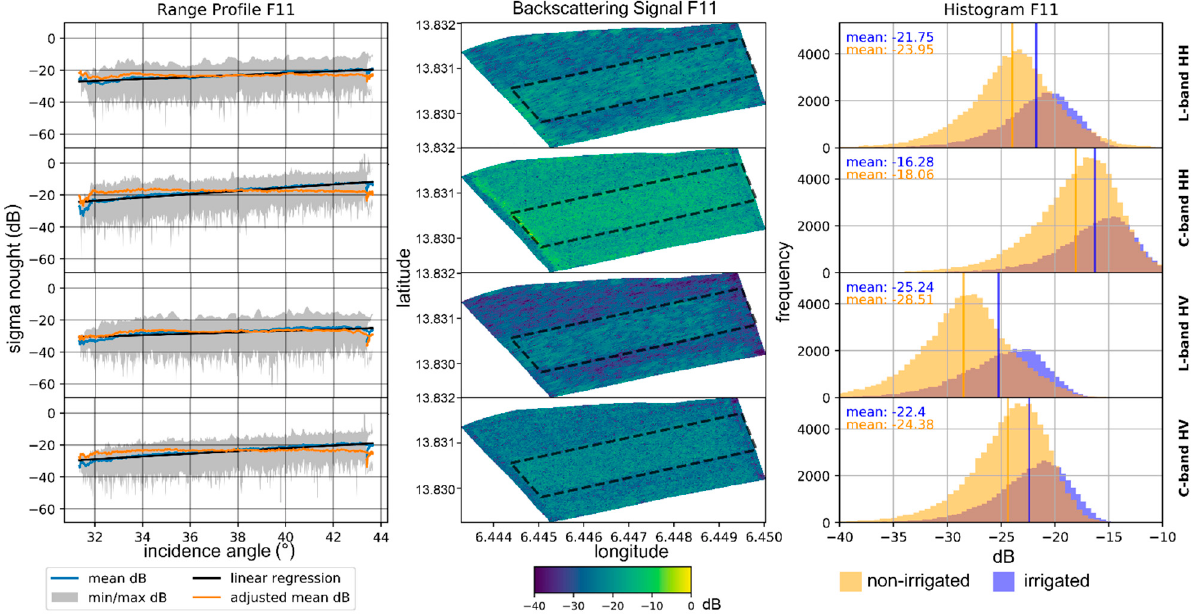
Figure 12. Observed and detrended range profile (left) of field F11, backscattering signal in decibels (dB) for irrigated and non-irrigated area (middle) and related histograms from both areas (right).